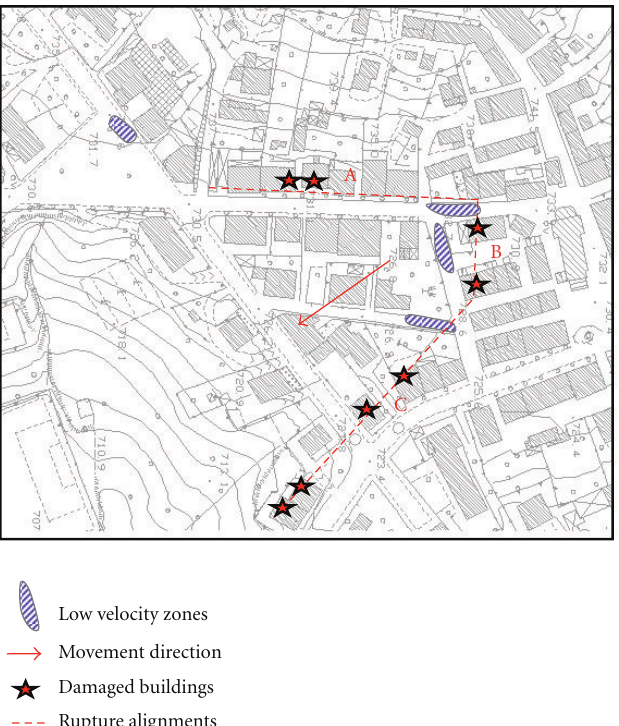
Figure 10: Location of main rupture zones, buildings a ff ected by marked damage, and low-velocity zones detected by seismic refraction. The arrow indicates the main direction of movement in the area and the dashed lines the rupture